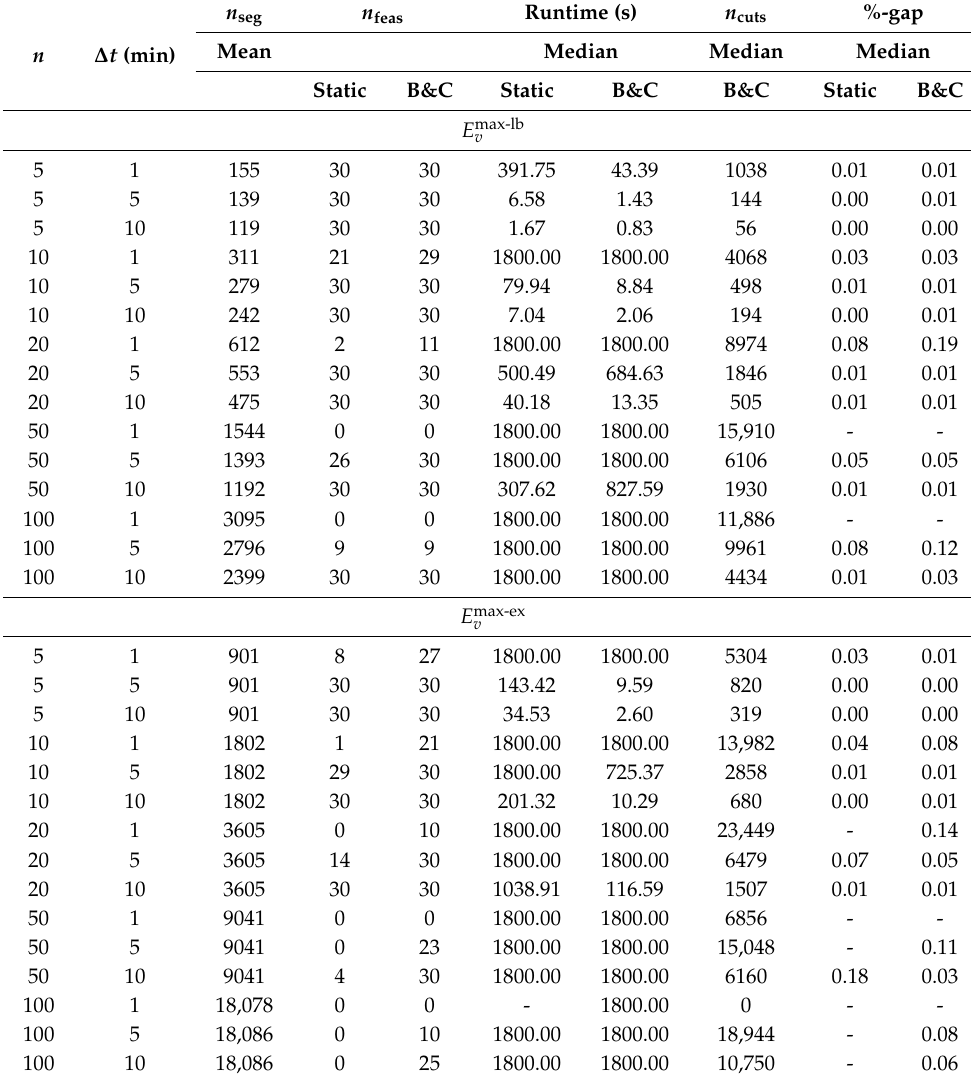
Table 3. EVS-SOC-GLIN results for solving the static model versus B&C with E max-lb v and E max-ex